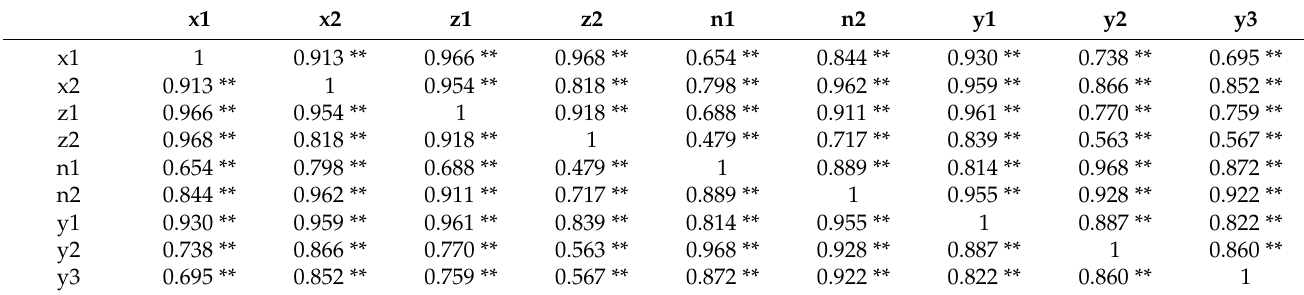
Figure 2. Error Bars of Variables for Efficiency Measurement. Table 4. Correlation Matrix (Spearman’s and Pearson’s Correlations).